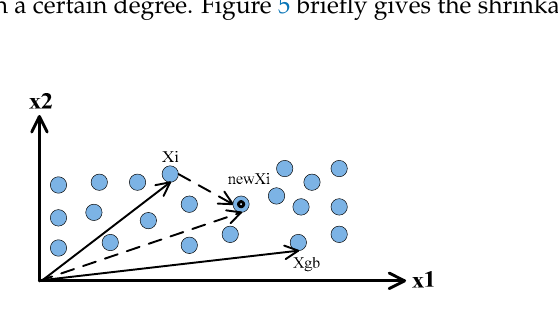
Figure 5. The shrinkage trend of elements towards the optimal point.